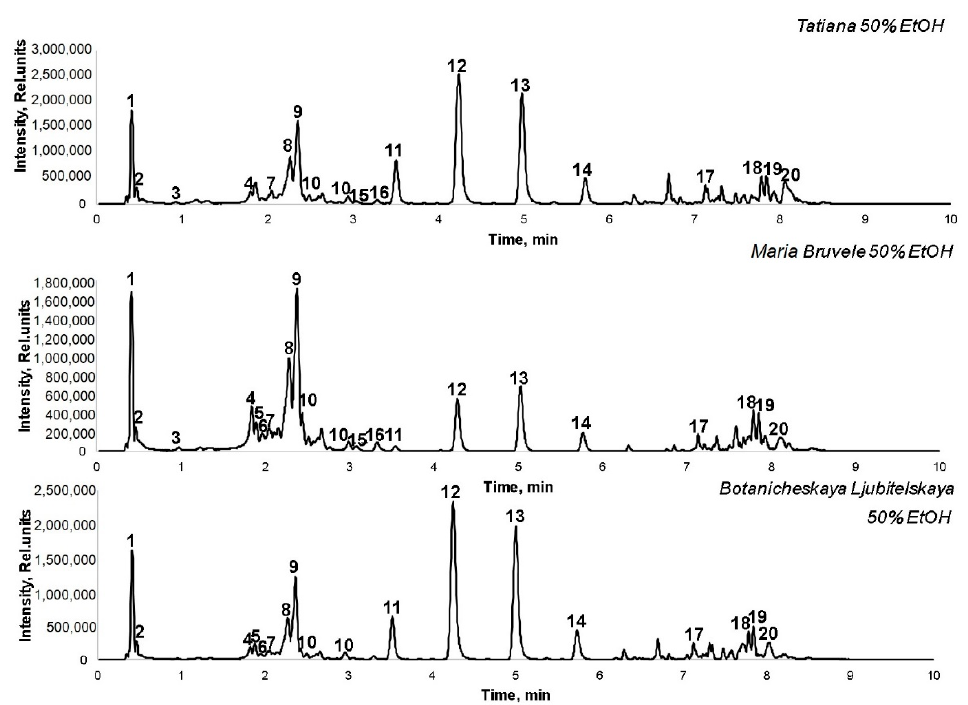
Figure 3. UHPLC-TOF/MS chromatograms of 50% EtOH extracts of SBT samples.